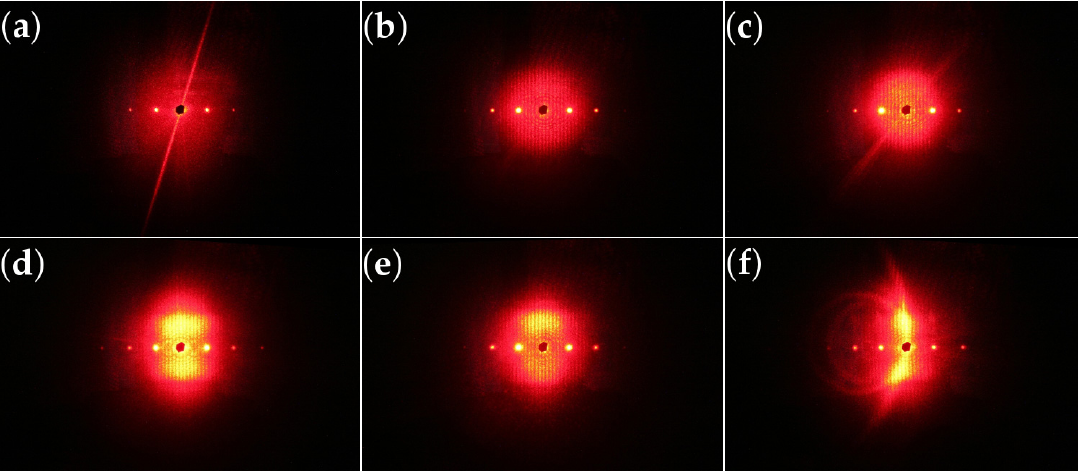
Figure 7. HS: Far-field light-induced scattering patterns on a screen behind the sample. Photos were taken after recording when the sample is illuminated with the probe He-Ne laser beam at the Bragg angle for λ r . The central black spot is to mask the transmitted beam on the screen to avoid overexposure of the photo taken. t p = 12 s and: ( a ) d 0 = 20 µ m; ( b ) d 0 = 50 µ m; ( c ) d 0 = 85 µ m; ( d ) d 0 = 125 µ m or t p = 90 s; and ( e ) d 0 = 125 µ m, respectively. In ( f ), we show diffraction cones (closed rings) for d 0 = 125 µ m, t p = 12 s due to the presence of parasitic gratings (PGs) (see the text) for an off-Bragg angle of θ r = 16 ◦